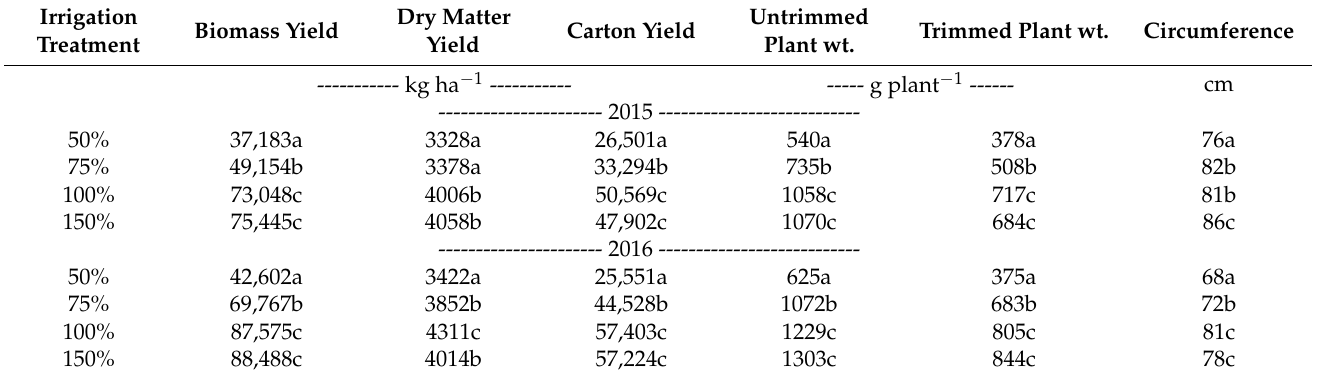
Table 2. Average biomass, dry matter, carton yield, plant weights, and head size of irrigation treatments from trials 1 and 2. Treatments are 50–150% of crop water requirement. Means with different letters are statistically different at the p < 0.05 confidence